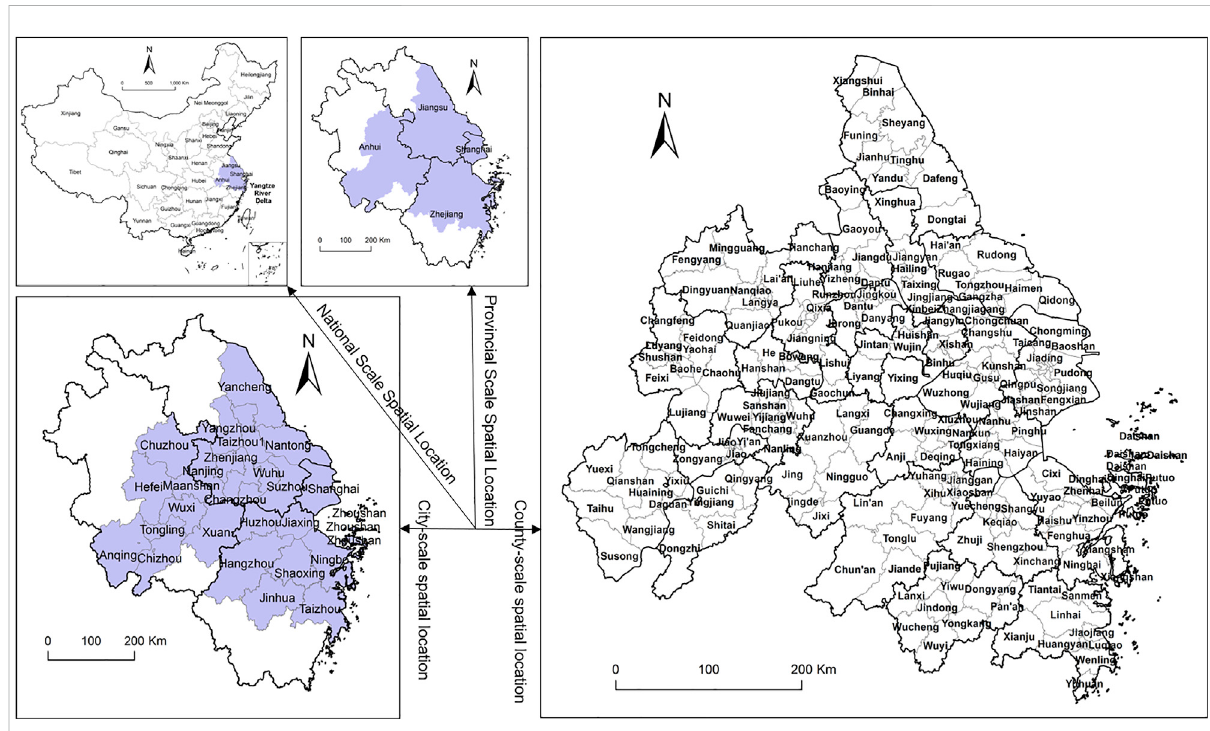
FIGURE 1 Distribution of the Yangtze River Delta region at four spatial scales: national, provincial, municipal and county. Note: Taizhou is Taizhou City, Jiangsu Province, and Taizhou1 is Taizhou City, Zhejiang